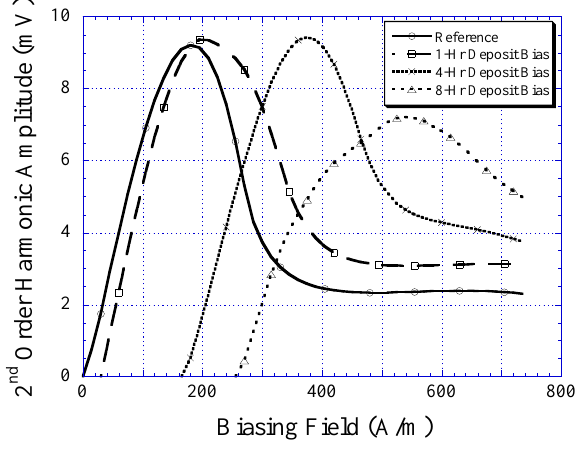
Figure 8. The 2nd-order harmonic shift produced by magnetically-soft material in the presence of 1, 4, and 8 h electroplated CoNiMnP